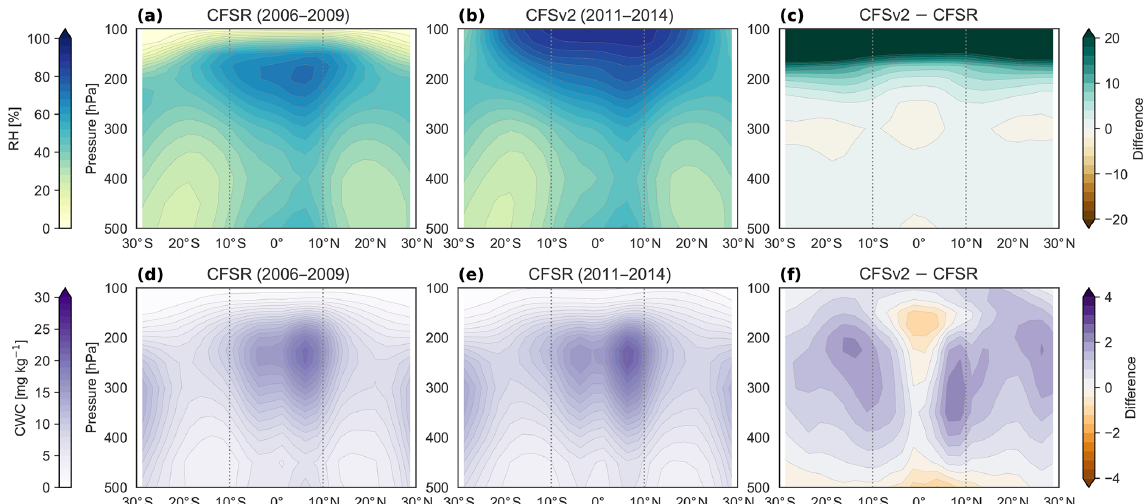
Figure B1. (a–c) Zonal-mean distributions of relative humidity based on (a) the last 4 years of the original CFSR (2006–2009) and (b) the first 4 years of CFSv2 (2011–2014), along with (c) the difference between the two products (in percentage points). (d–f) As in (a–c) but for cloud water content.